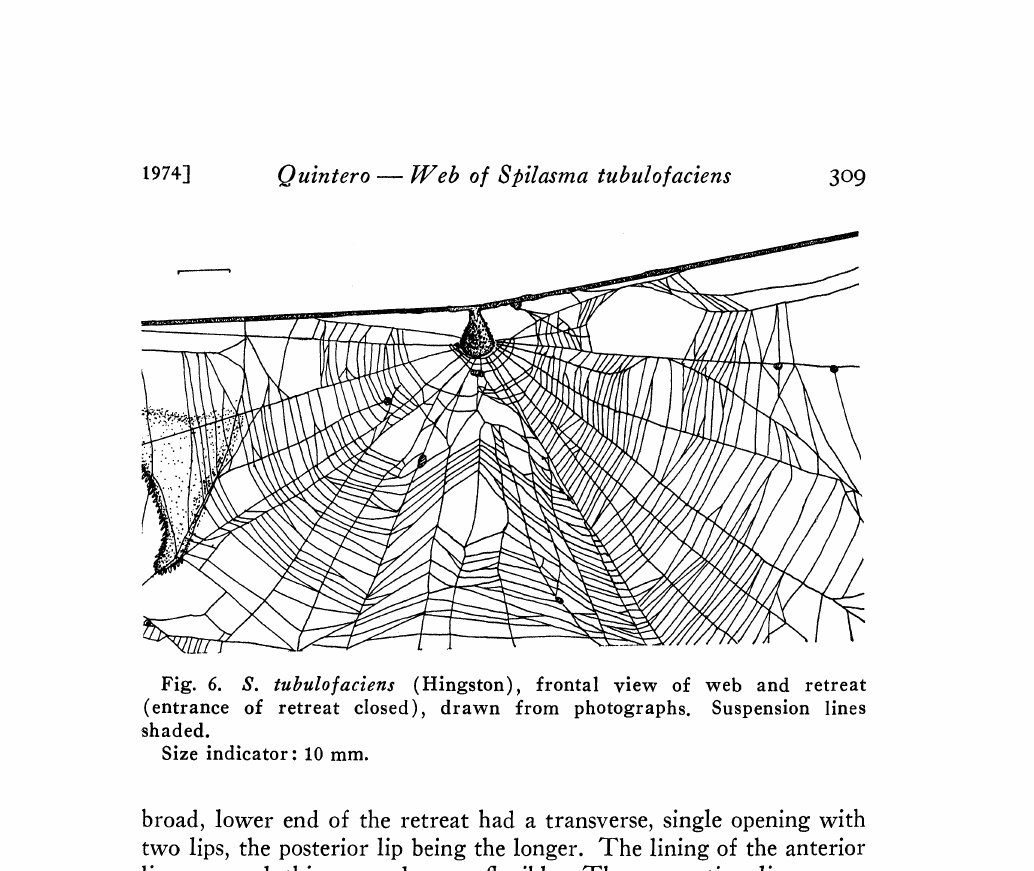
Fig. 6. S. tubulofaciens (Hingston), frontal view of web and retreat (entrance of retreat closed), drawn from photographs. Suspension lines shaded. Size indicator" 10